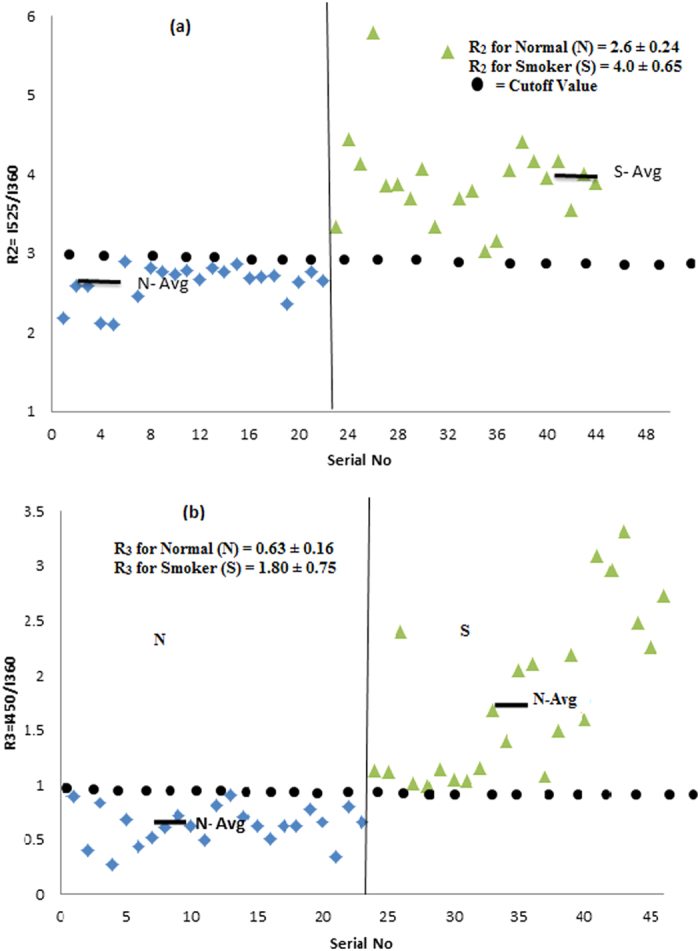
(a) Distribution of R2 = I525/I360 ratios, as obtained from Fig. 3. N- Control sample, S- Smoker sample. (b) Distribution of R3 = I450/I360 ratios, as obtained from Fig. 3. N- Control sample, S- Smoker sample.